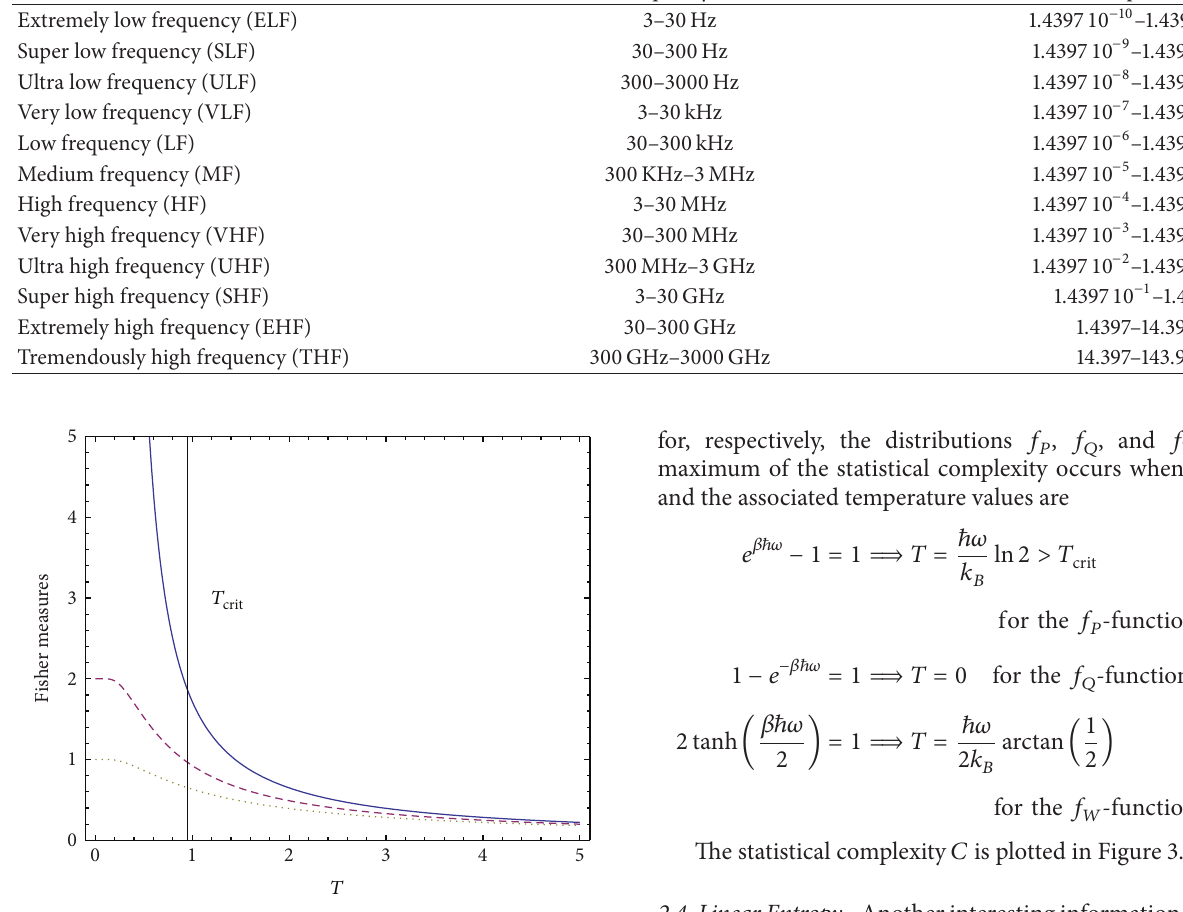
Figure 1: Fisher measure versus temperature 𝑇 expressed in ) -units. The solid line is the case 𝑃 , the dashed one is the (ℏ𝜔/𝑘 𝐵 Wigner one, and the dotted curve is assigned to the Husimi instance. The vertical line represents the critical temperature 𝑇